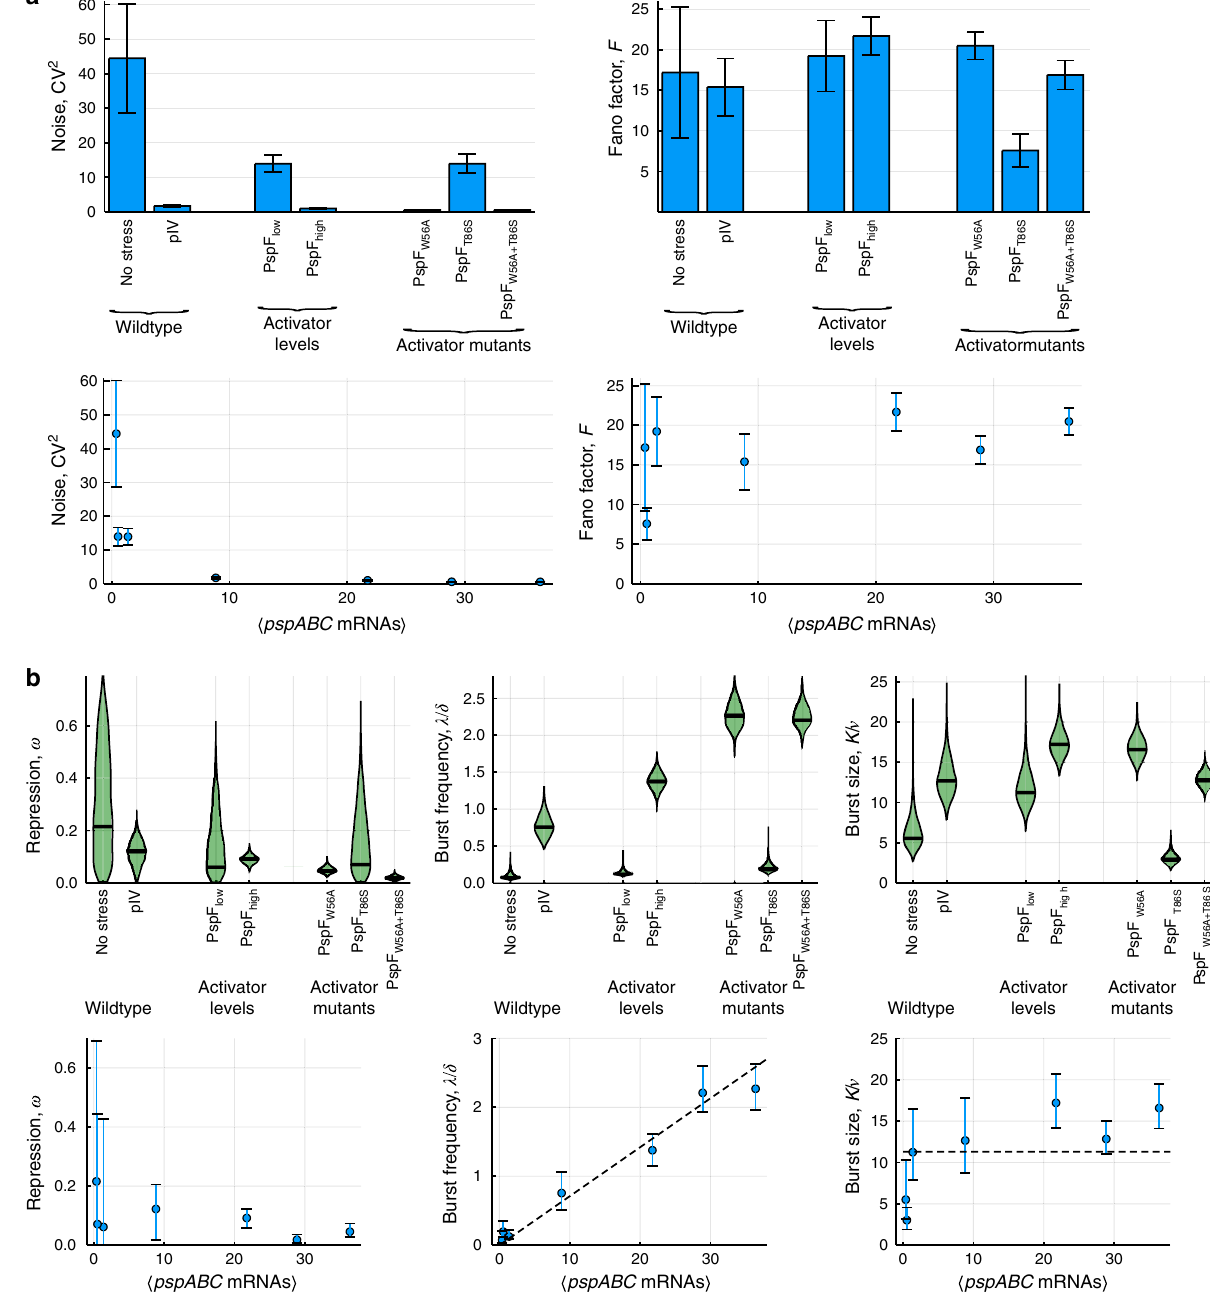
Fig. 6 Transcriptional noise and bursting of the σ 54 controlled Psp system. Wildtype E. coli cells grown in absence (no stress) and presence of membrane